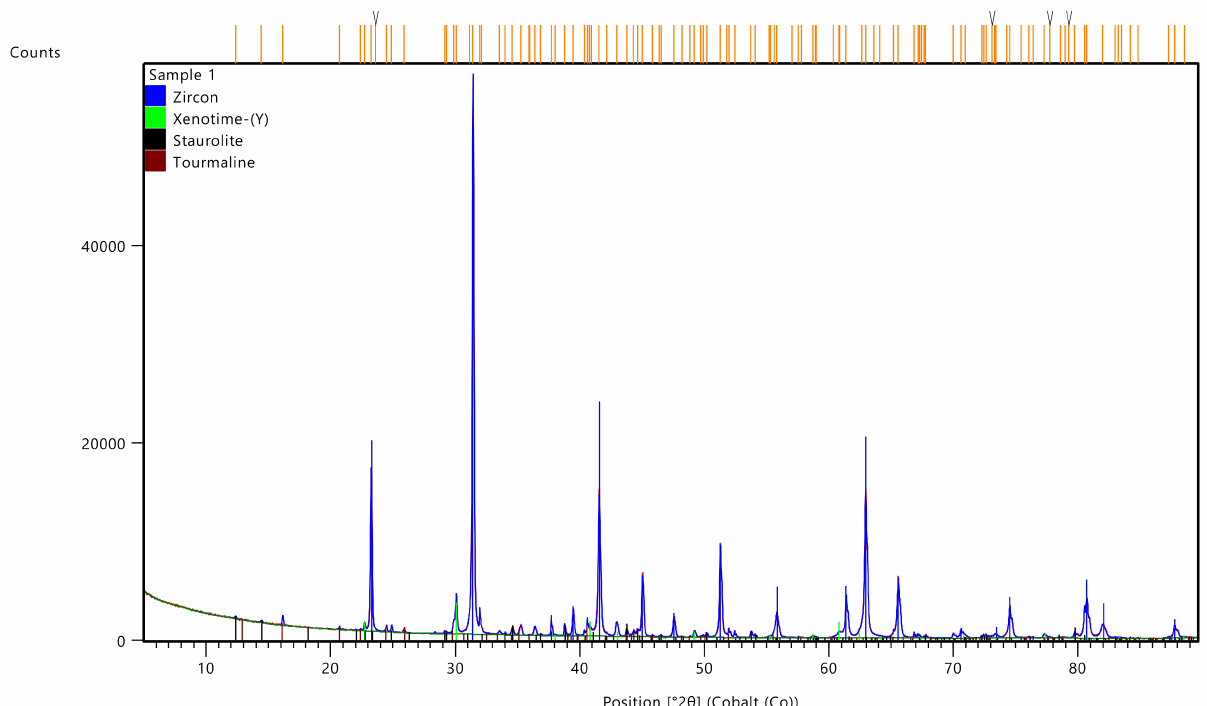
Figure 5. XRD diffractogram: Residue from 30 min leach, Perth